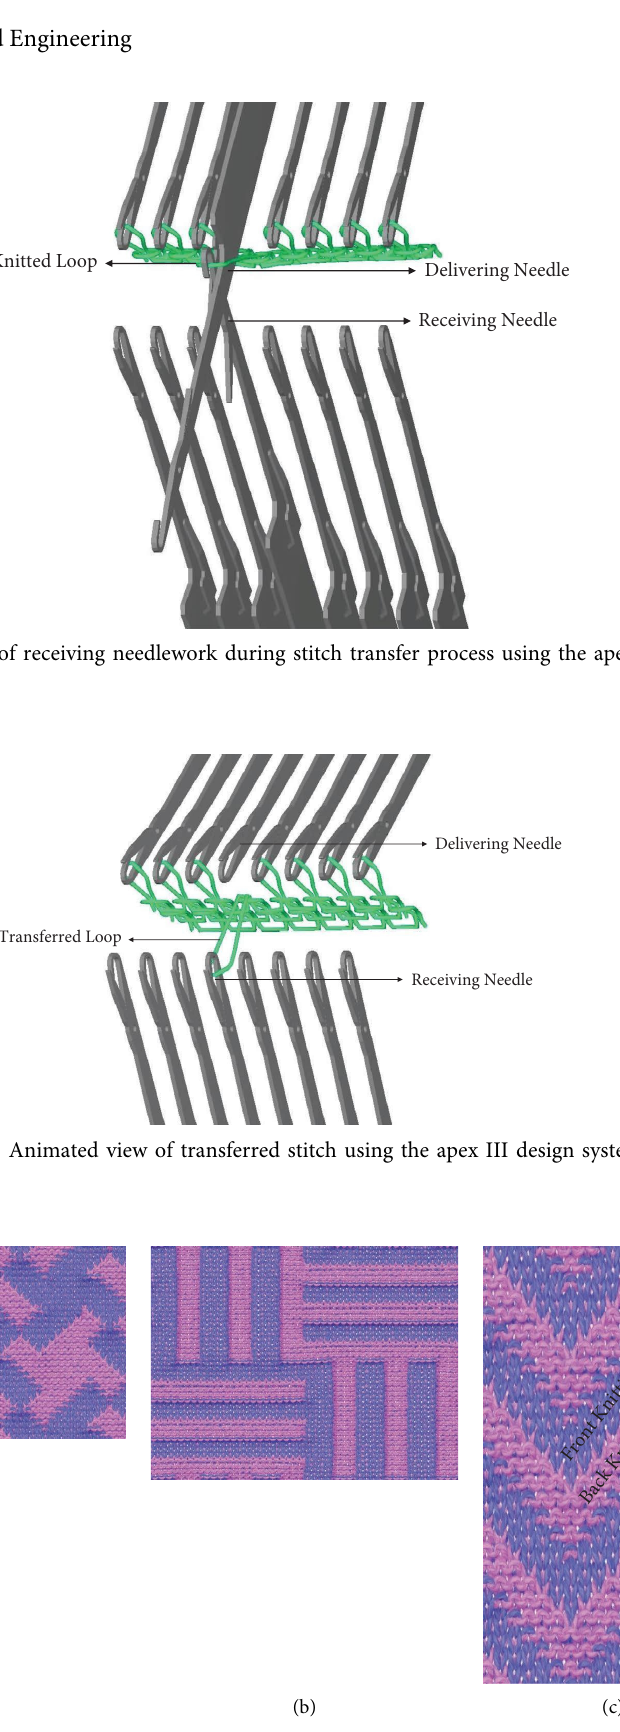
Figure 8: Virtual simulation of structures: (a) star, (b) lines, and (c)